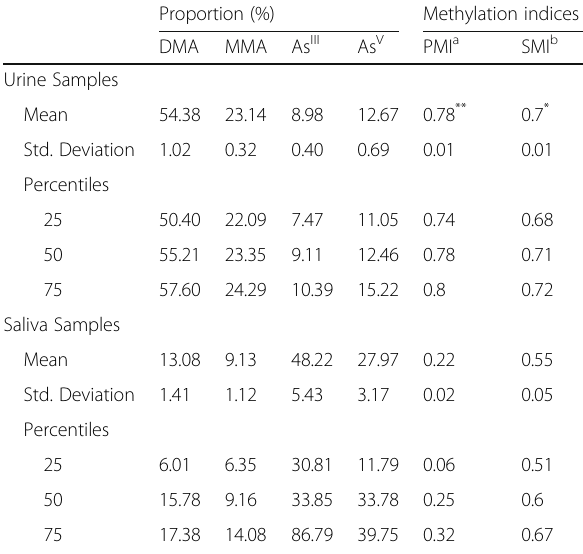
Table 4 Proportion of different arsenic species (DMA, MMA, As III , and As V ) and methylation indices in urine and saliva